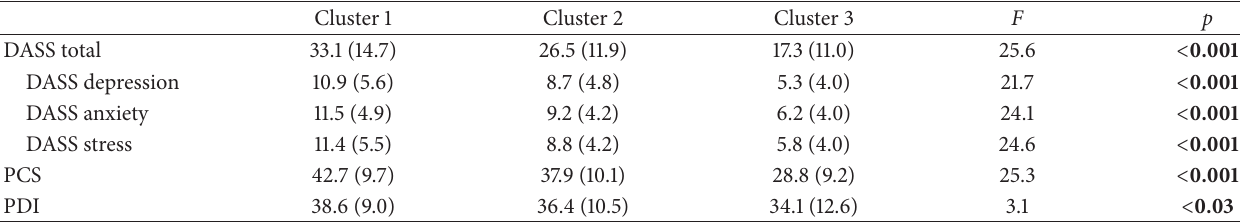
Table 2: Mean values (standard deviation) in mood, catastrophizing, and pain disability among the cluster subgroups.